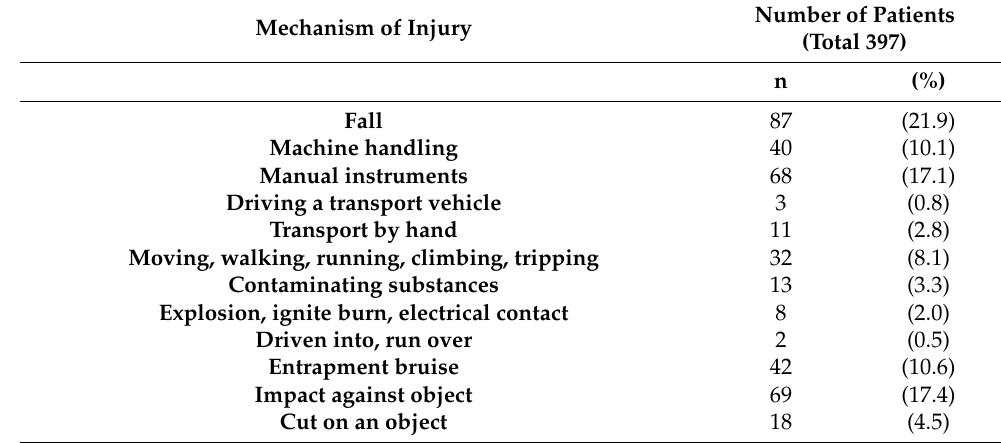
Figure 2. Relationship between the injured body part reported and the length of hospital stay. Outliers are indicated with symbol “ × ”. Table 3. Distribution of work-related accidents by mechanism of injury among construction workers in Switzerland between 2016 and